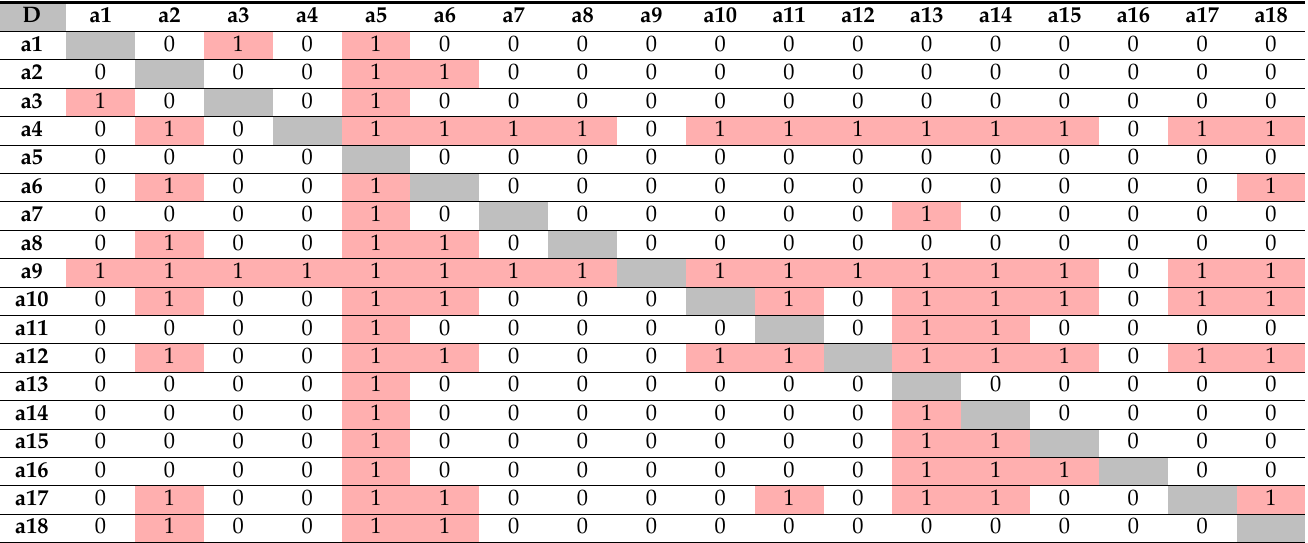
Table 15. Selection matrix generated by the condition defined by the concordance and discordance and